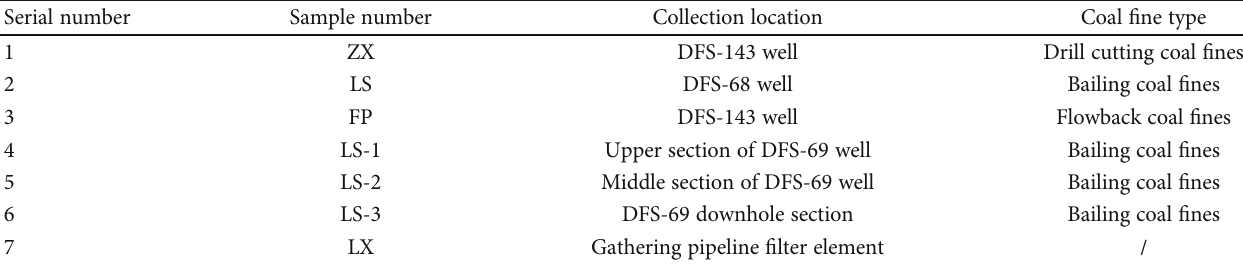
Figure 1: Tectonic outline of the Huanglong coal fi eld. Table 1: Basic information of coal fi ne sample